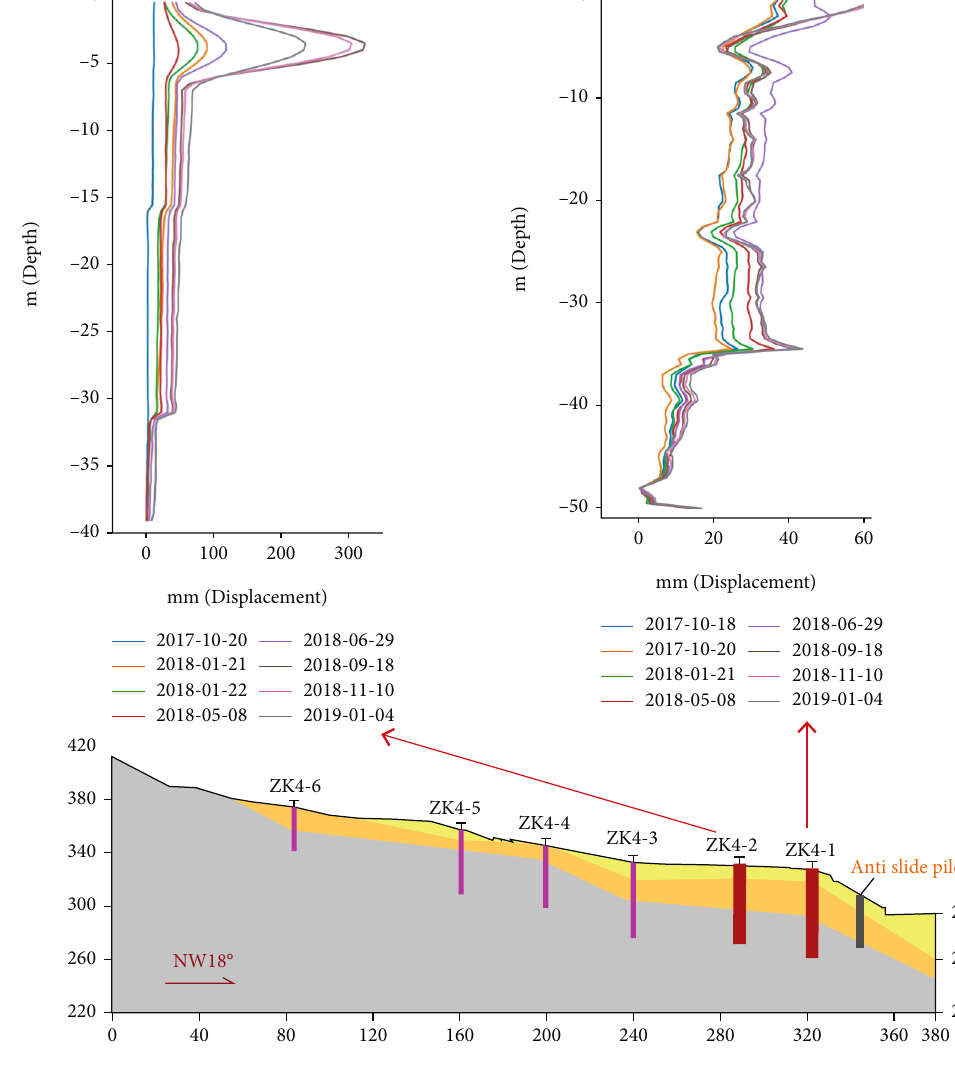
Figure 12: Cumulative displacement-depth curves of ZK4-1 and ZK4-2